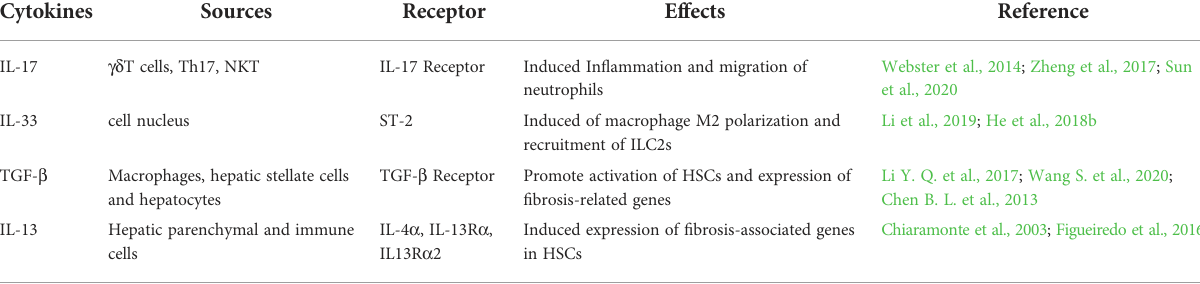
TABLE 2 The role of cytokines in schistosoma-associated liver fi